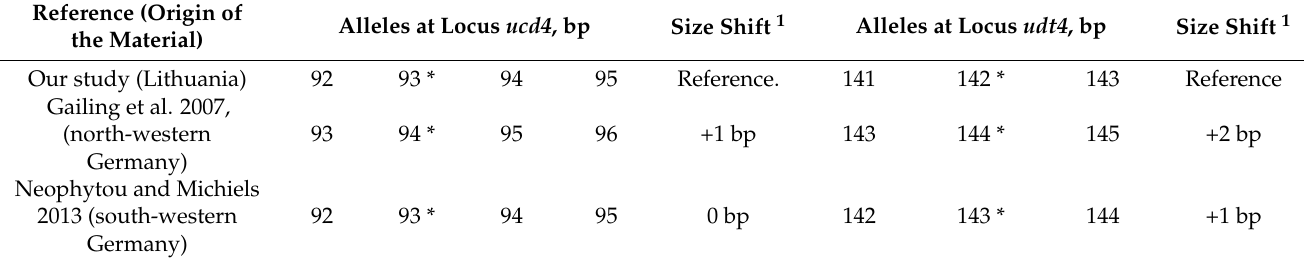
Table 3. Synchronizing the alleles for the two cpSSR loci from our and the two other studies on Q. robur with the aim to assign the cpSSR haplotypes to the postglacial migration lineages by [19]. Q. robur. The table includes all alleles found at the loci in all three